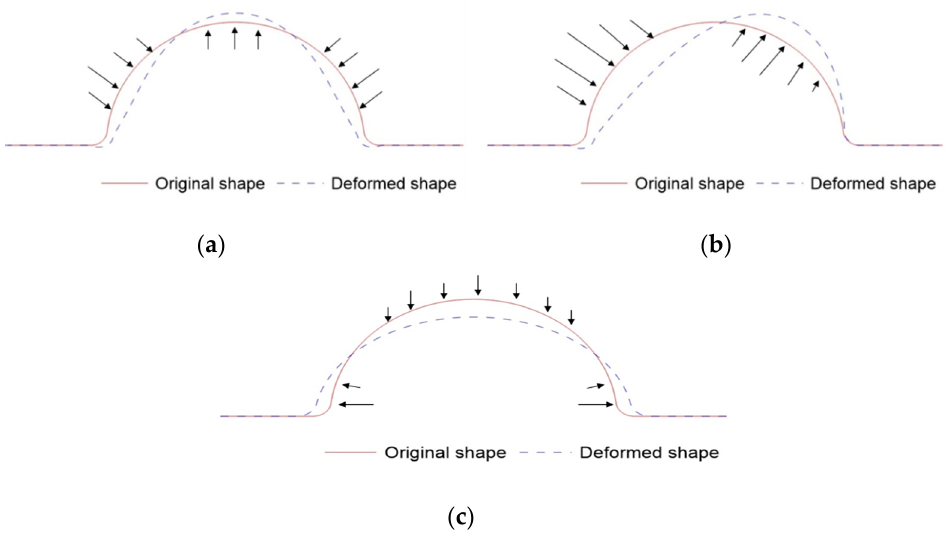
(d) Figure 10. Deformation direction of the SPB on the length–middle section in the ( a ) symmetric pressure analysis, ( b ) asymmetric pressure analysis, and ( c ) thermal shrinkage analysis. The black arrows represent the deformation direction of the node from the red line to the blue dashed line.